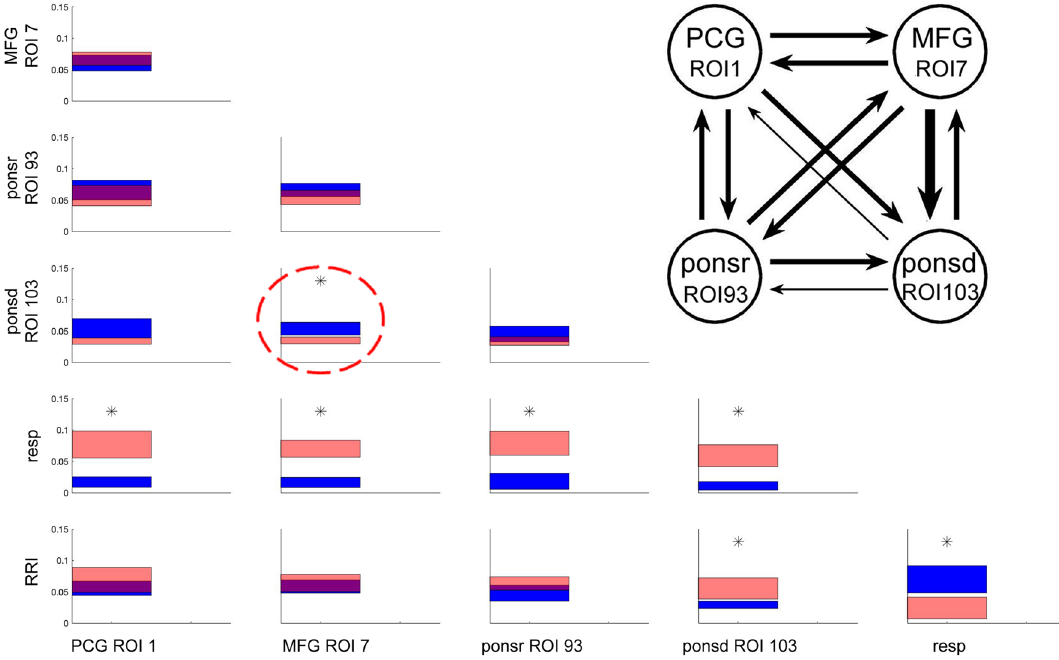
Figure 4. Directed coupling strengths for LA group in 0.05–0.15 Hz frequency band. Each box shows the strength of coupling as a position on the vertical axis. The width of bars is proportional to the mean error. The blue color shows the flow from the signal marked below the given column to the signal marked at the left, and the red color the flow from the signal marked at left to the signal marked below. Significant differences between couplings of inflow and outflow are marked by stars ( p < 0.05). Note, significant flow from MFG (ROI 7) to caudal pons structure (ponsd, ROI 103) (marked by a stippled circle). The insert shows the coupling strength for BOLD signals only. Each arrow indicates the direction and the strength of information flow.